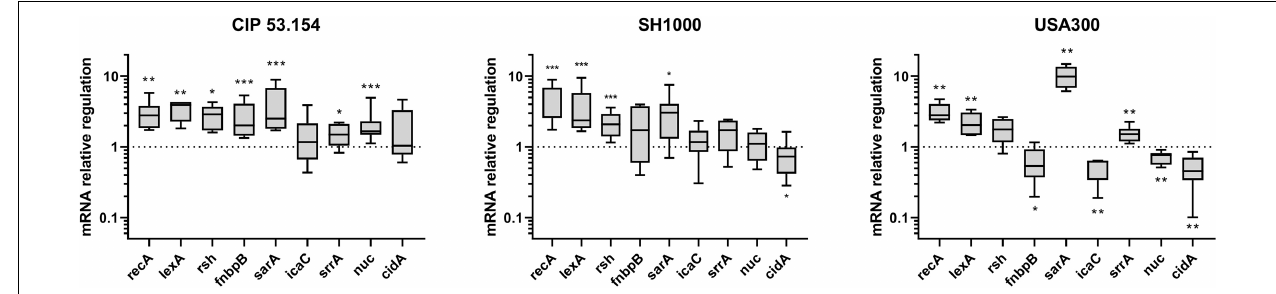
FIGURE 7 | Impact of starvation, magnesium excess, and hypoxia on S. aureus gene regulation. Biofilms were grown in minimal medium (MM) or in modified minimal medium (BLE: no CAA, without casamino acids; 10 × Mg, 10 × minimal medium concentration; no Gluc, without glucose) without oxygen for 24 h before RT-qPCR analysis. Results represent the ratio of relative mRNA expressions of bacteria within biofilms grown in BLE vs. those grown in minimal medium. Experiments were performed eight independent times with two technical replicates for each. Results are presented as box and whiskers: whiskers represent minimum and maximum, the bottom and top of the box are the 15th and 85th percentiles, and the black band inside the box stands for the median. Statistical analyses were performed using the exact non-parametric Wilcoxon–Mann–Whitney test for independent samples: *, **, ***Statistically different from minimal medium without oxygen ( p < 0.05; p < 0.01; p <